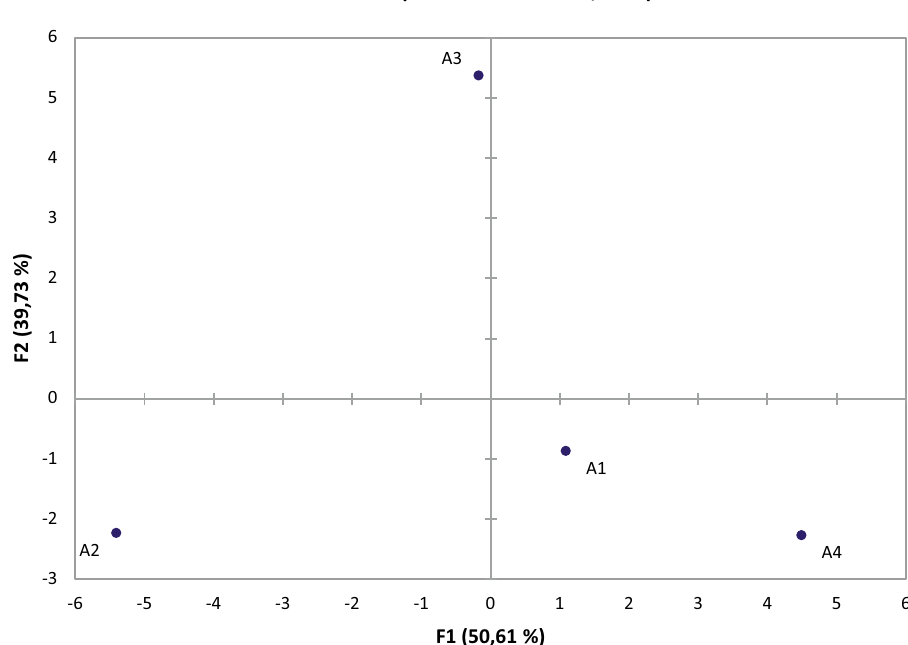
Fig. 11 Principal component plot showing objects (A1‑A4) clustering in 2D space (F1 and F2 factors